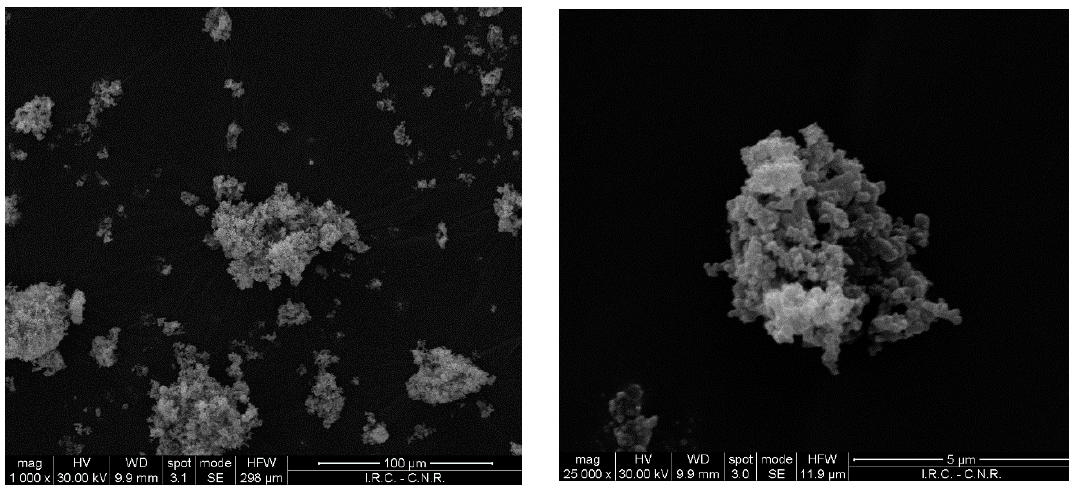
Figure 2. SEM images of the soot sample.